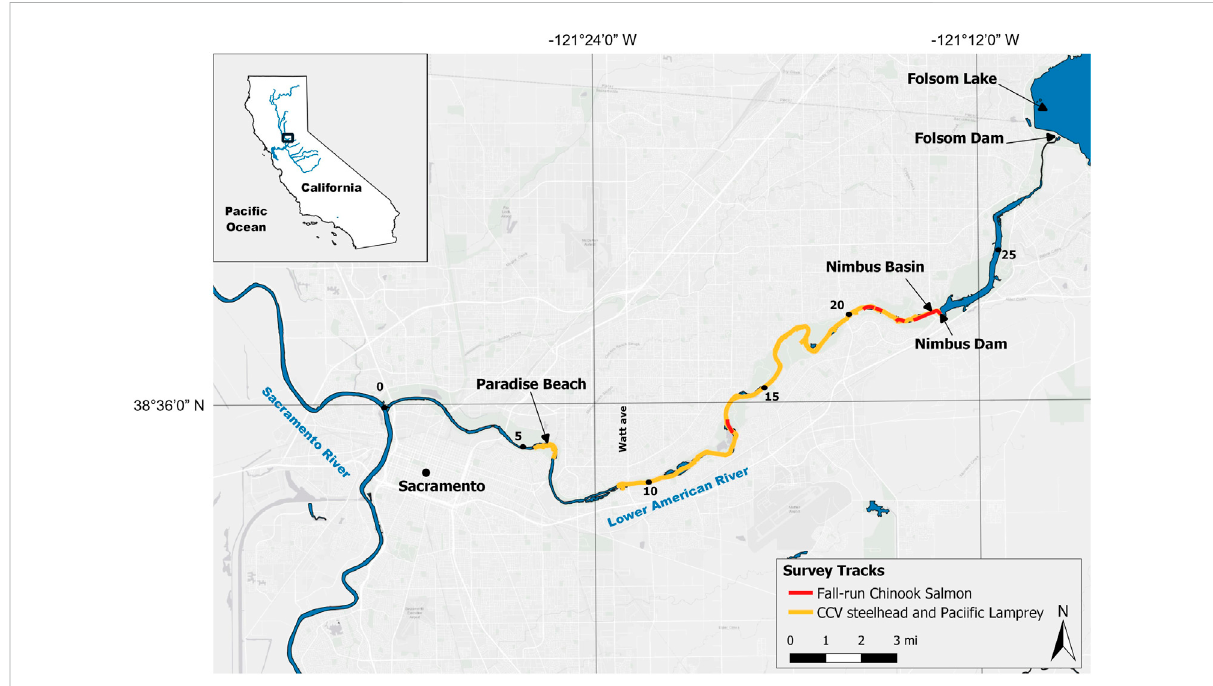
FIGURE 1 Map of the Lower American River in California. Yellow lines represent areas where CCV steelhead and Paci fi c Lamprey spawning surveys were conducted, and red lines represent areas where fall-run Chinook Salmon spawning surveys were conducted. River miles are represented by black dots with the con fl uence of the Lower American River and Sacramento River beginning at river mile